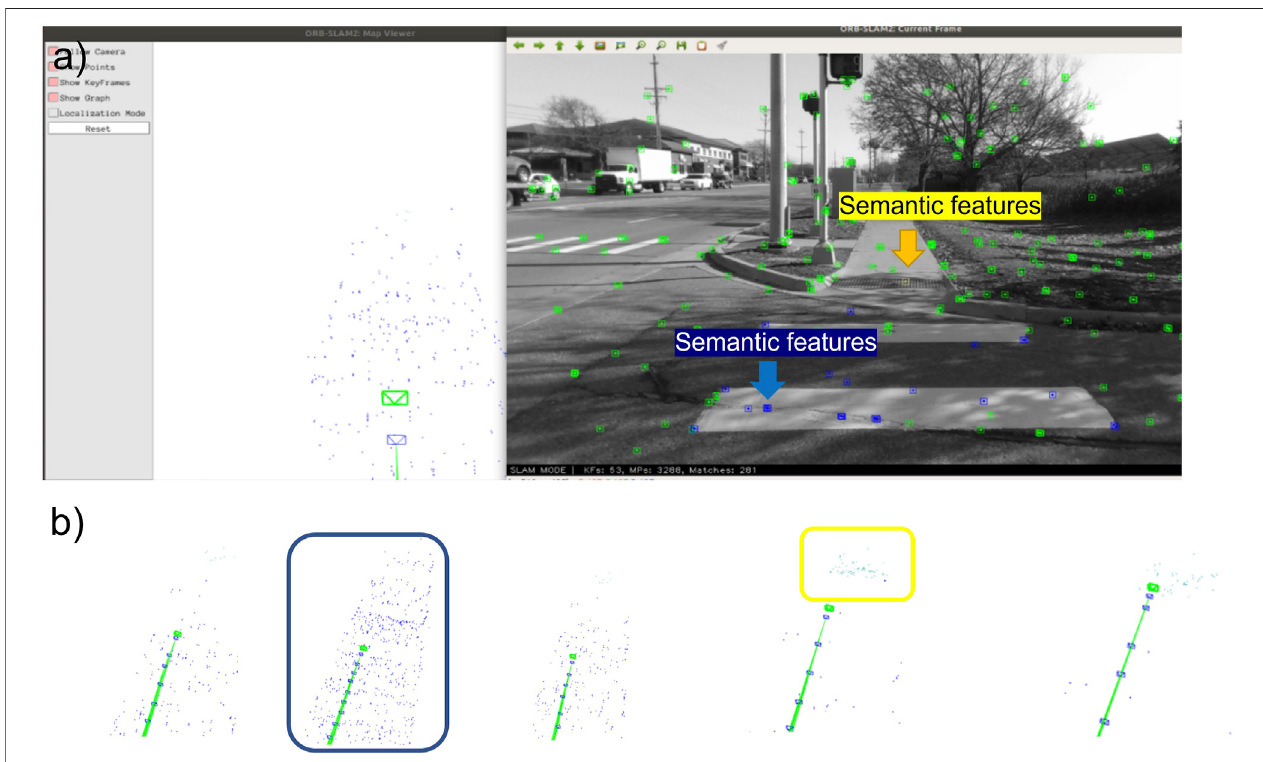
FIGURE 6 | The fi gure shows semantic associated features in different colors. The blue dots mean crosswalk and the yellow is target destination (texture plates). The green dots are keypoints not associated with semantic information. The green dots in panel (A) are keypoints not associated with semantic information. Panel (B) is zoomed view of trajectory. The small blue rectangles are earlier keyframes, and the green small rectangle means current estimated camera pose.